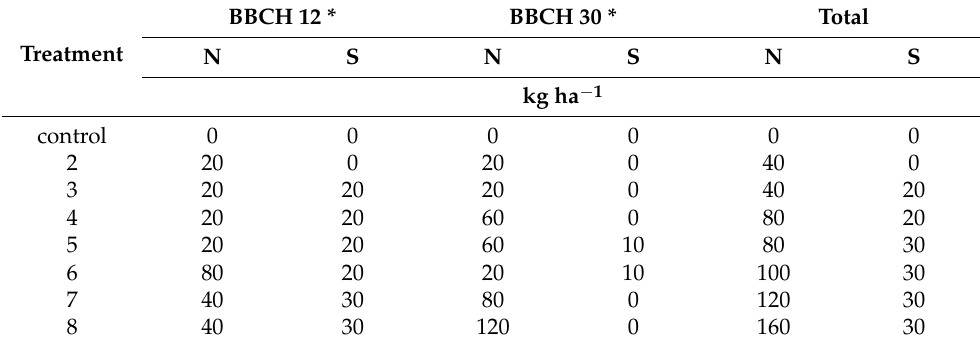
Table 1. Nitrogen and sulfur fertilization rate by carinata phenological stage.